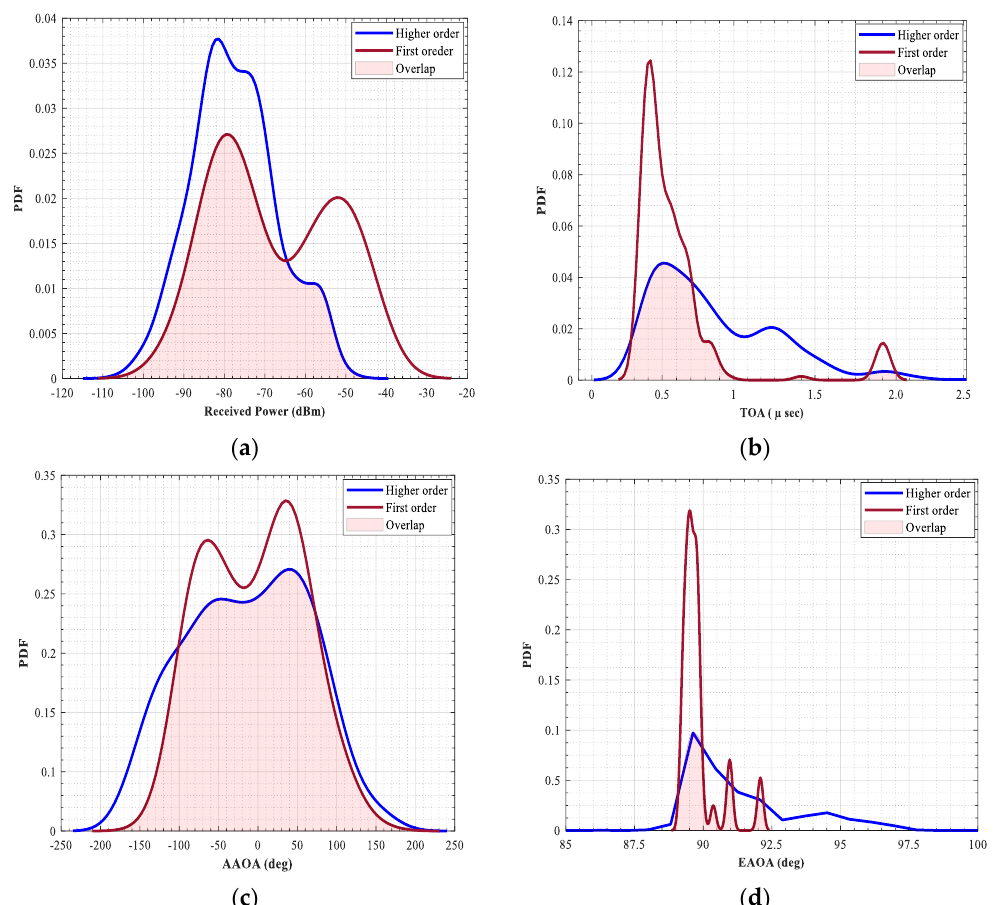
Figure 7. PDF of different extracted characteristics: ( a ) Received power, ( b ) TOA, ( c ) AAOA, and ( d ) EAOA.